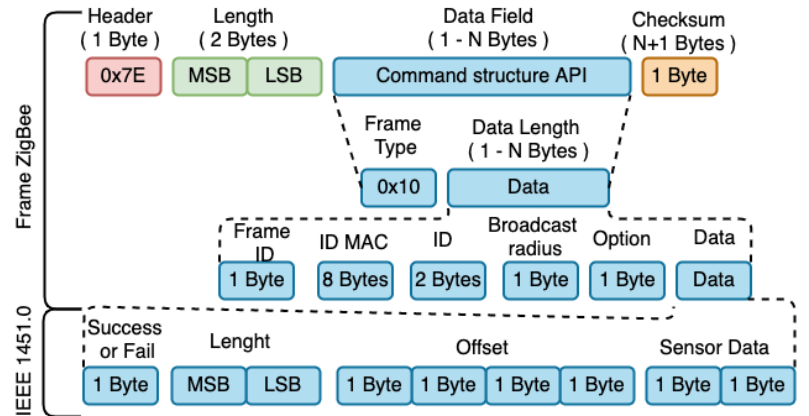
Figure 9. Response command.